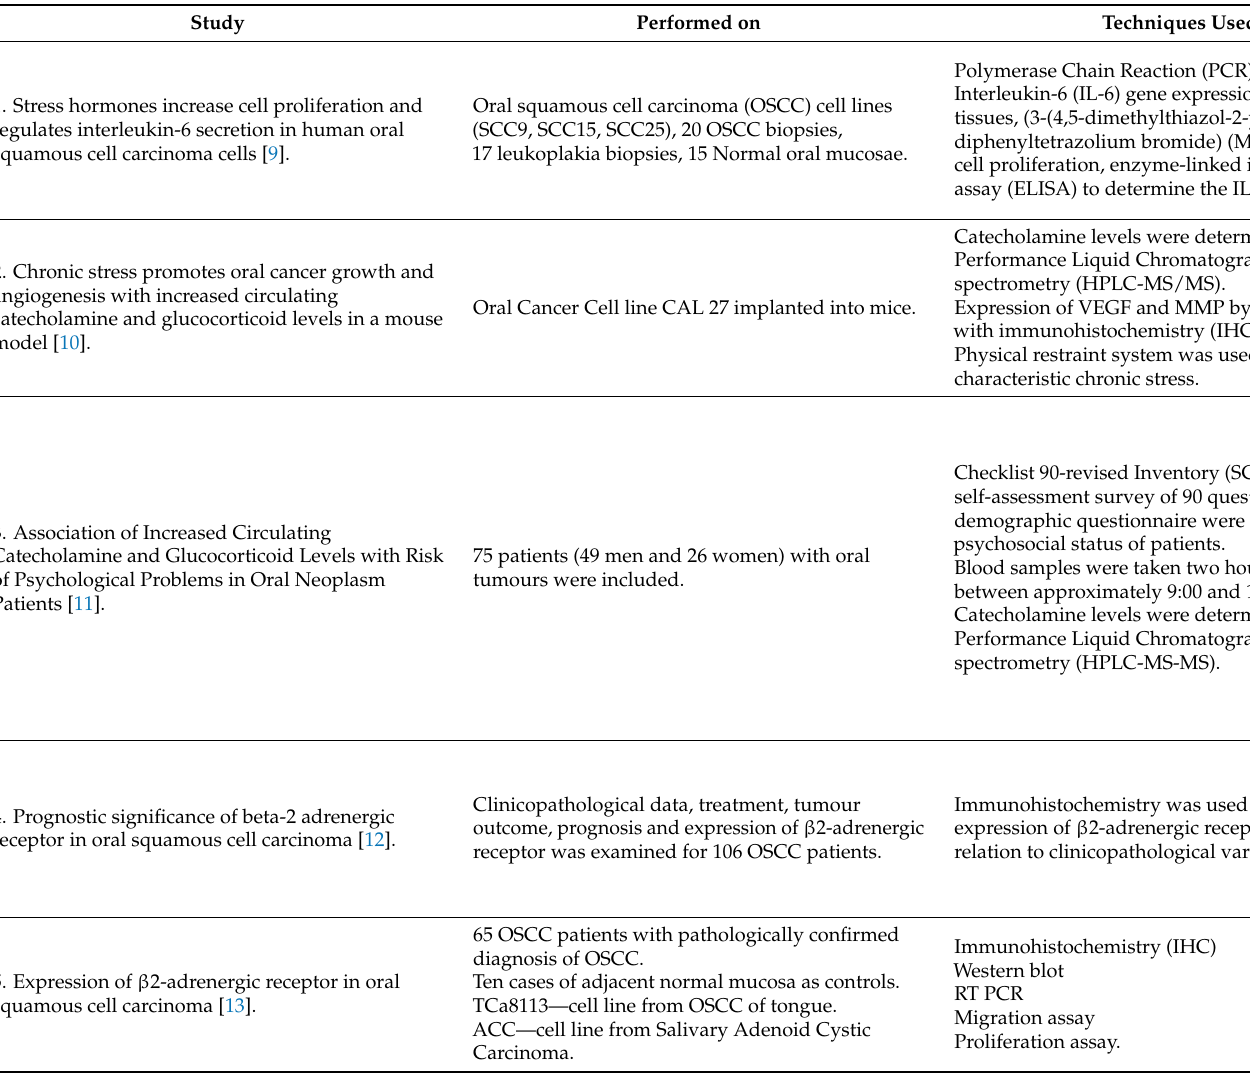
Table 1. Studies on Head and Neck Cancer Showing the Effect of Stress Hormones and